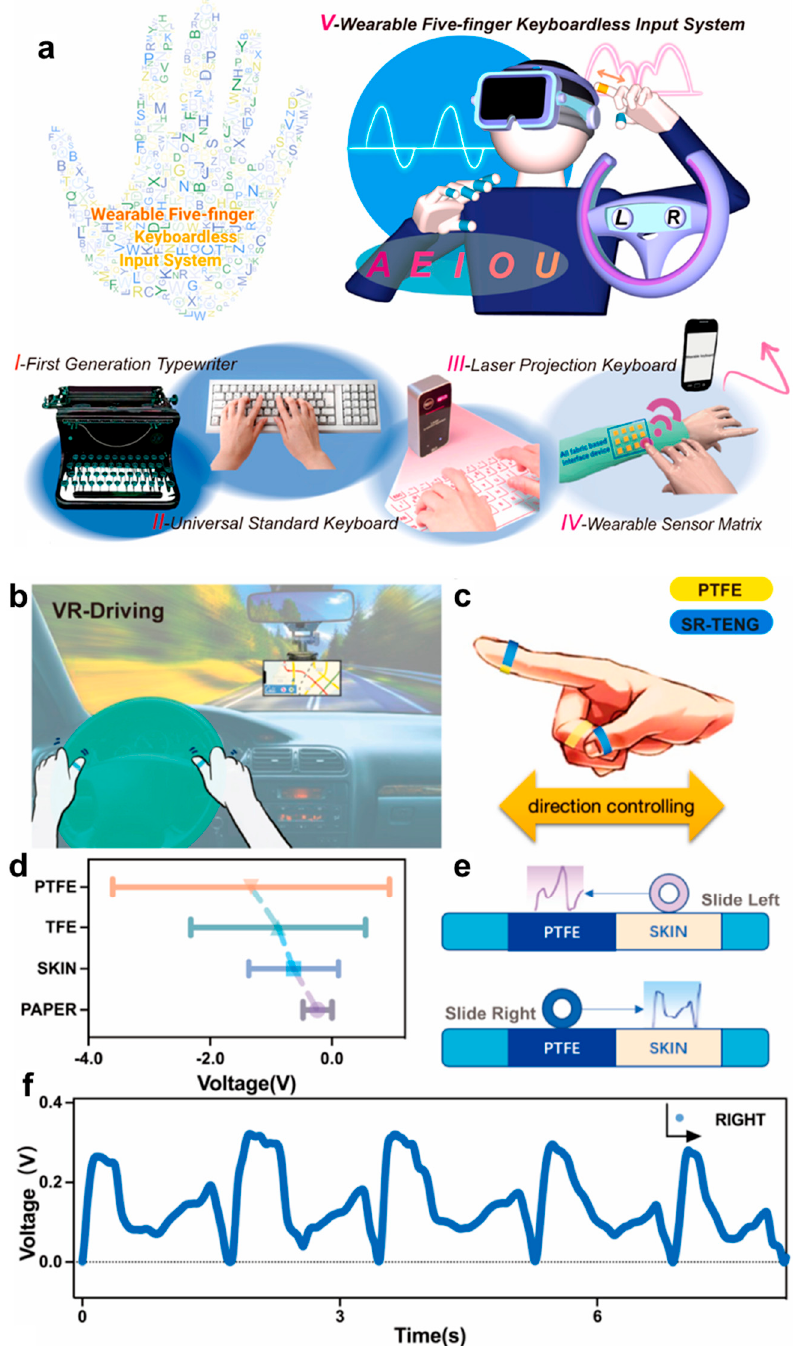
Figure 8. Concept and application of SF ring TENG (SR-TENG) in wearable keyboardless input system. ( a ) The development process of keyboard. ( b ) Schematic illustration for application of SR- TENG in VR driving. ( c ) Direction controlling realized by SR-TENG during finger sliding. ( d ) Voltage changing range with different materials contacting with SR-TENG. ( e ) Schematic diagram of direction controlling by SR-TENG. ( f ) Voltage variation produced by SR-TENG during sliding to right [158].